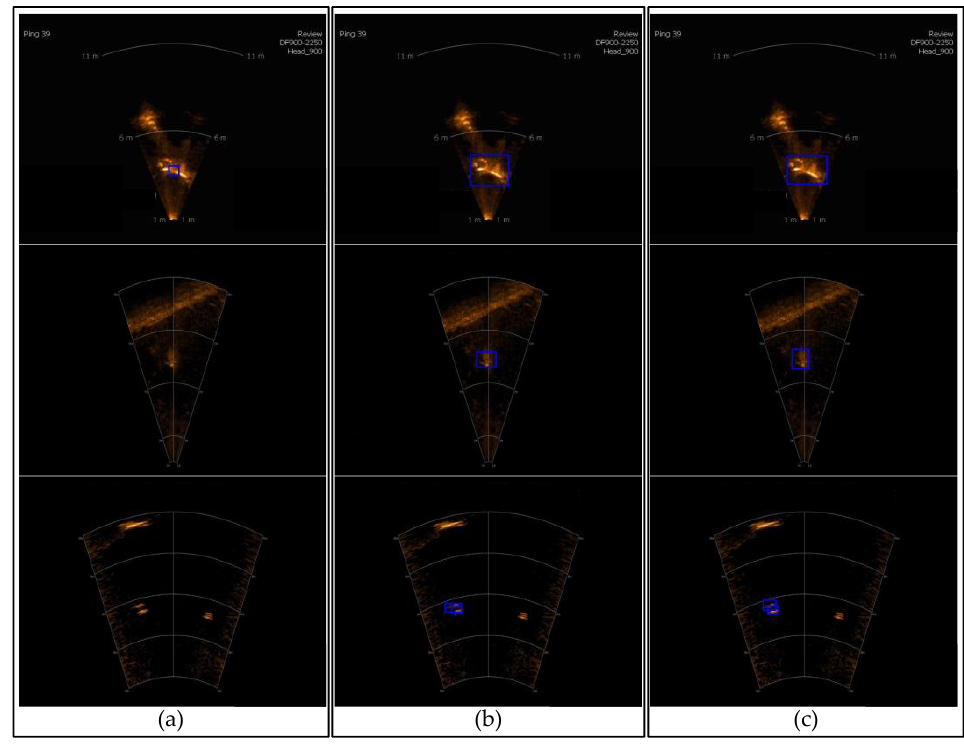
Figure 18. Detection results for typical forward-looking sonar images: ( a ) were detection results of 𝐷 𝑑𝑖𝑟𝑒𝑐𝑡−𝑡𝑟𝑎𝑖𝑛 , ( b ) were detection results of 𝐷 𝑏𝑎𝑠𝑖𝑐−𝑓𝑖𝑛𝑒𝑡𝑢𝑛𝑒 , and ( c ) were detection results of our method.